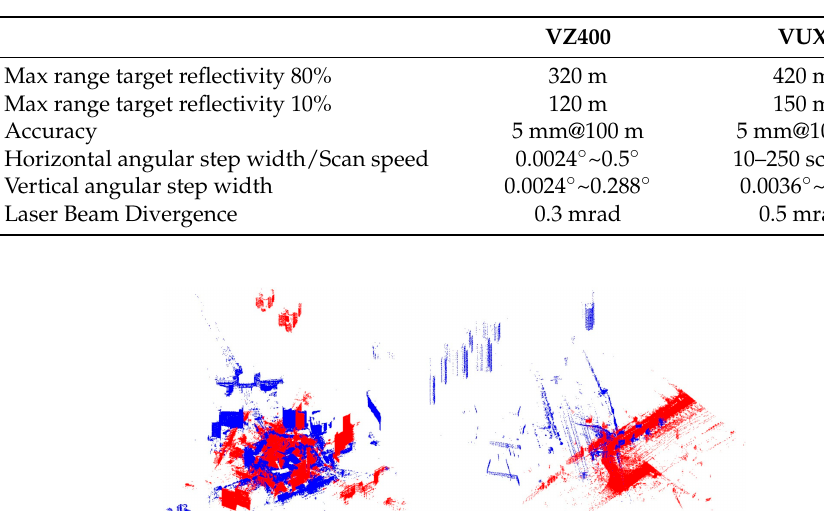
Table 1. The important specifications of 3D Riegl VZ400 and 2D Riegl VUX [49].